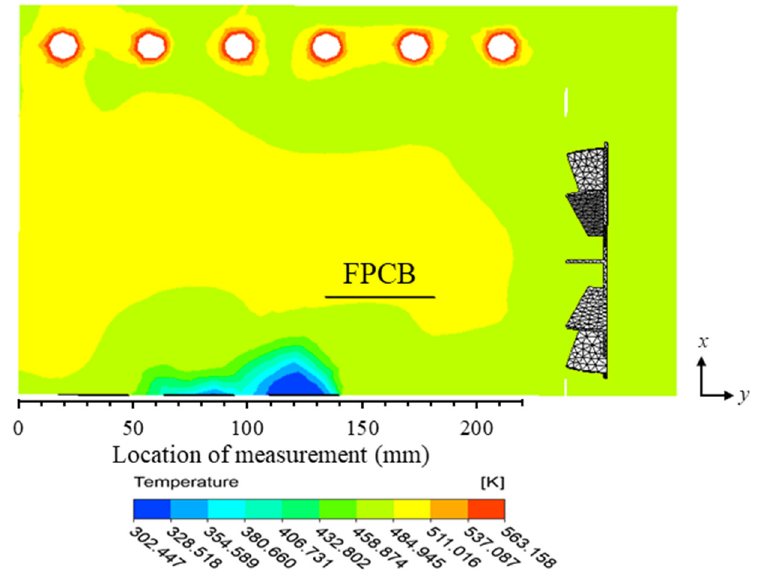
Figure 12. Temperature contour of the middle region with FPCB in the back position.